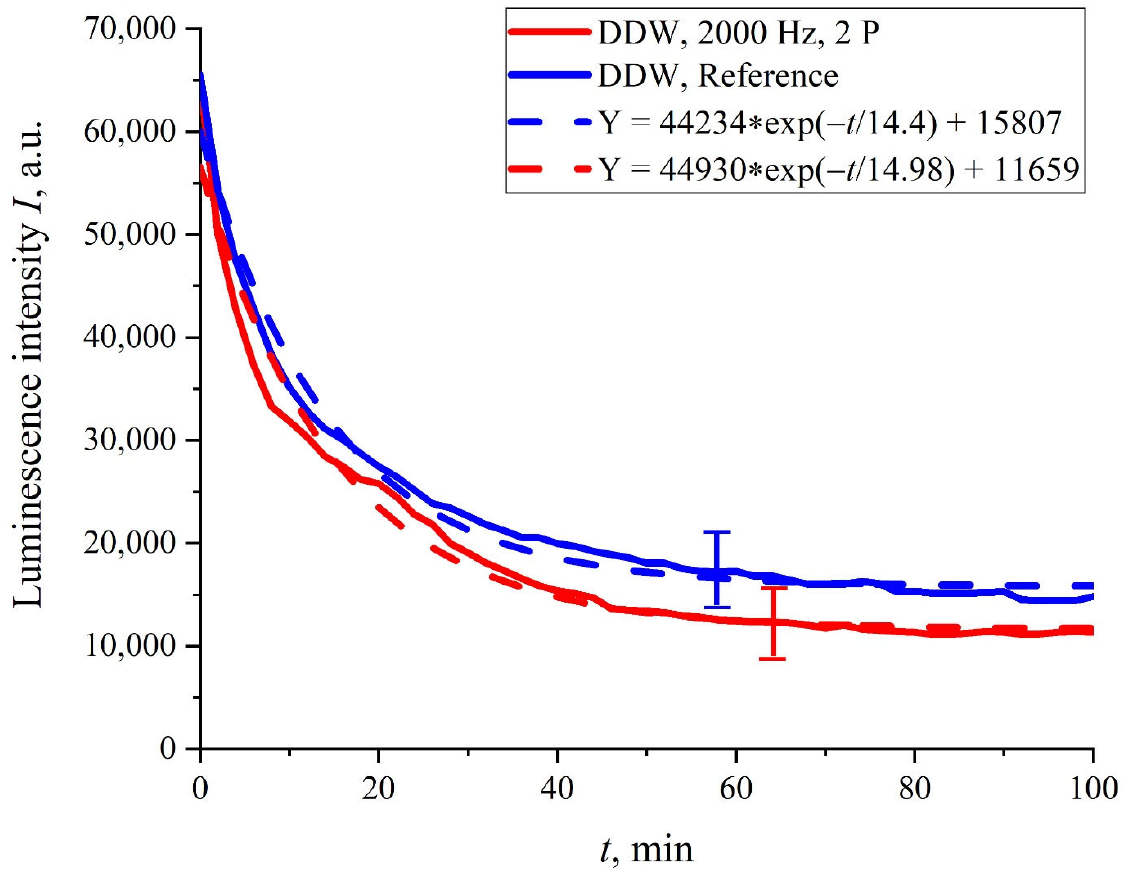
Figure 6. The intensity of the luminescence I ( t ) vs. soaking time t in DDW upon ultrasonic irradiation with two piezoelectric transducers.